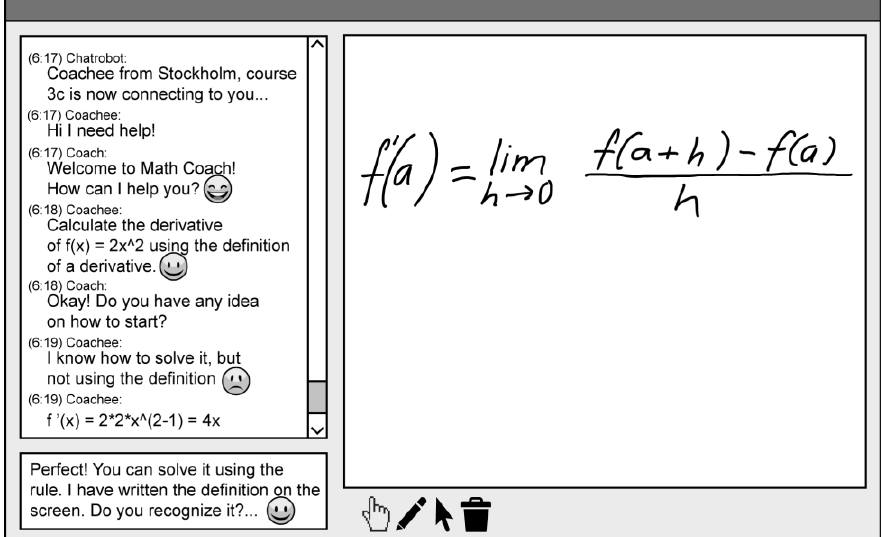
Figure 1 . Example of a math coach